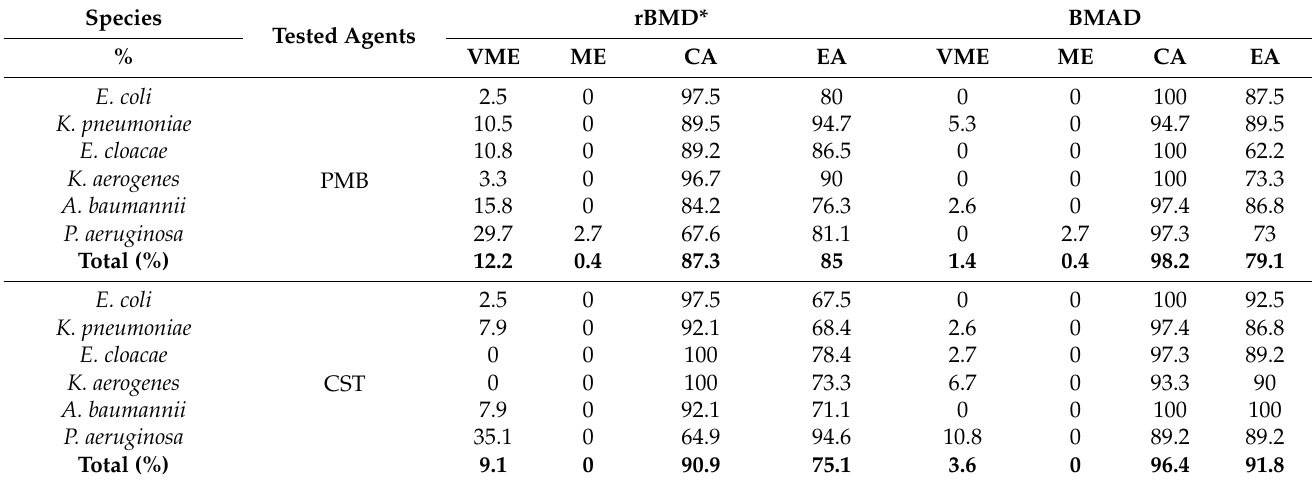
Table 3. AD Compared with rBMD and BMAD for polymyxin B and